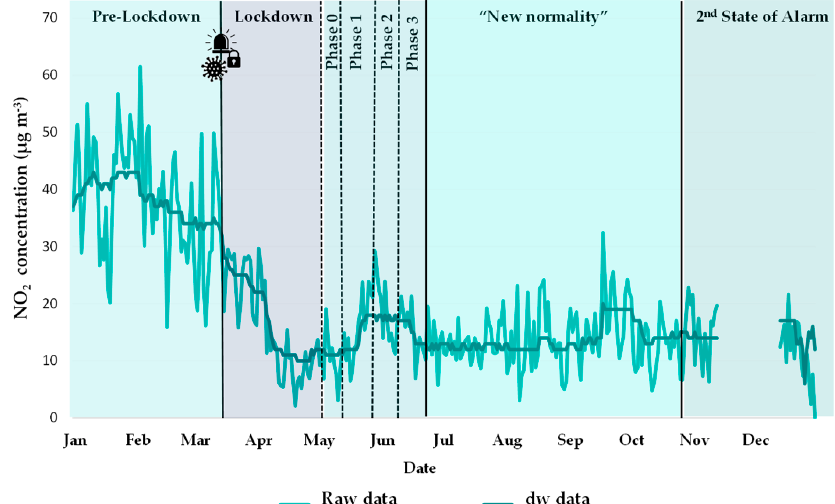
Figure 3. Removal of meteorological variability from the raw data of 2020 for NO 2 at the Santander Centro site using the “deweather” package.